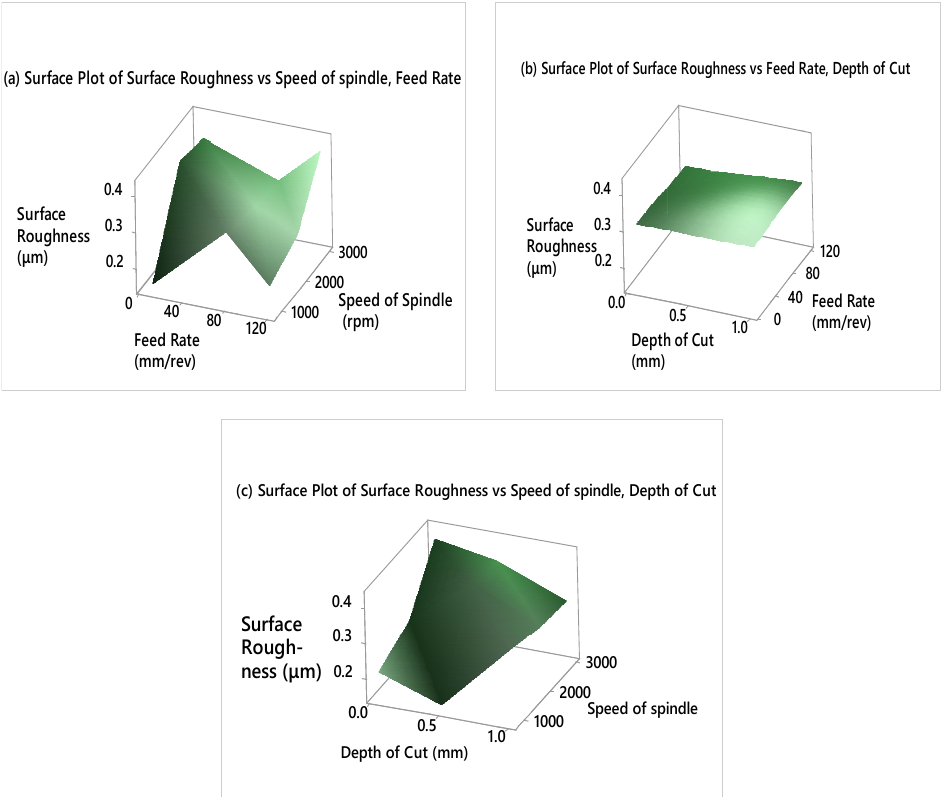
Figure 11. Surface plots of surface roughness against different combinations of process parameters ( a )surface roughness vs. spindle speed and feed rate, ( b ) surface plot of surface roughness vs. feed rate and depth of cut, ( c ) surface plot of surface roughness vs. spindle speed and depth of cut. Determining the significance of process variables, finding the main effect plot, interaction plot, and surface plots are vital stages in the whole process. After these stages, it is important to find whether the data follow any distribution or not. A normality test is conducted on the chosen data in MINITAB software to find their normal distribution. For normal distribution, sample data is taken from normally distributed data. ANOVA shows the significance of each parameter, while a normality test shows the significance of the overall data. Figure 12 shows the results of normality test.